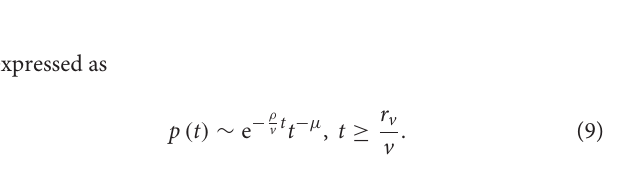
FIGURE 10 | A typical example of foraging procedure with λ = 0.5 and µ = 3.